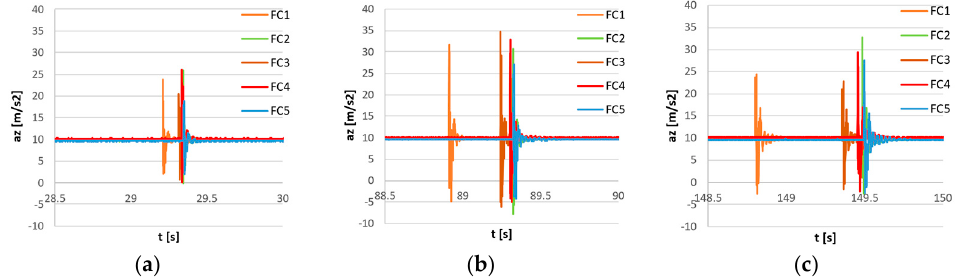
Figure 13. The raw measurement of impulse excitation (acceleration in Z-axis) of 5 flight controller sensors (FC1–FC5) before synchronization. Magnifications of the first pulse ( a ), the middle pulse ( b ), and the last pulse ( c ).